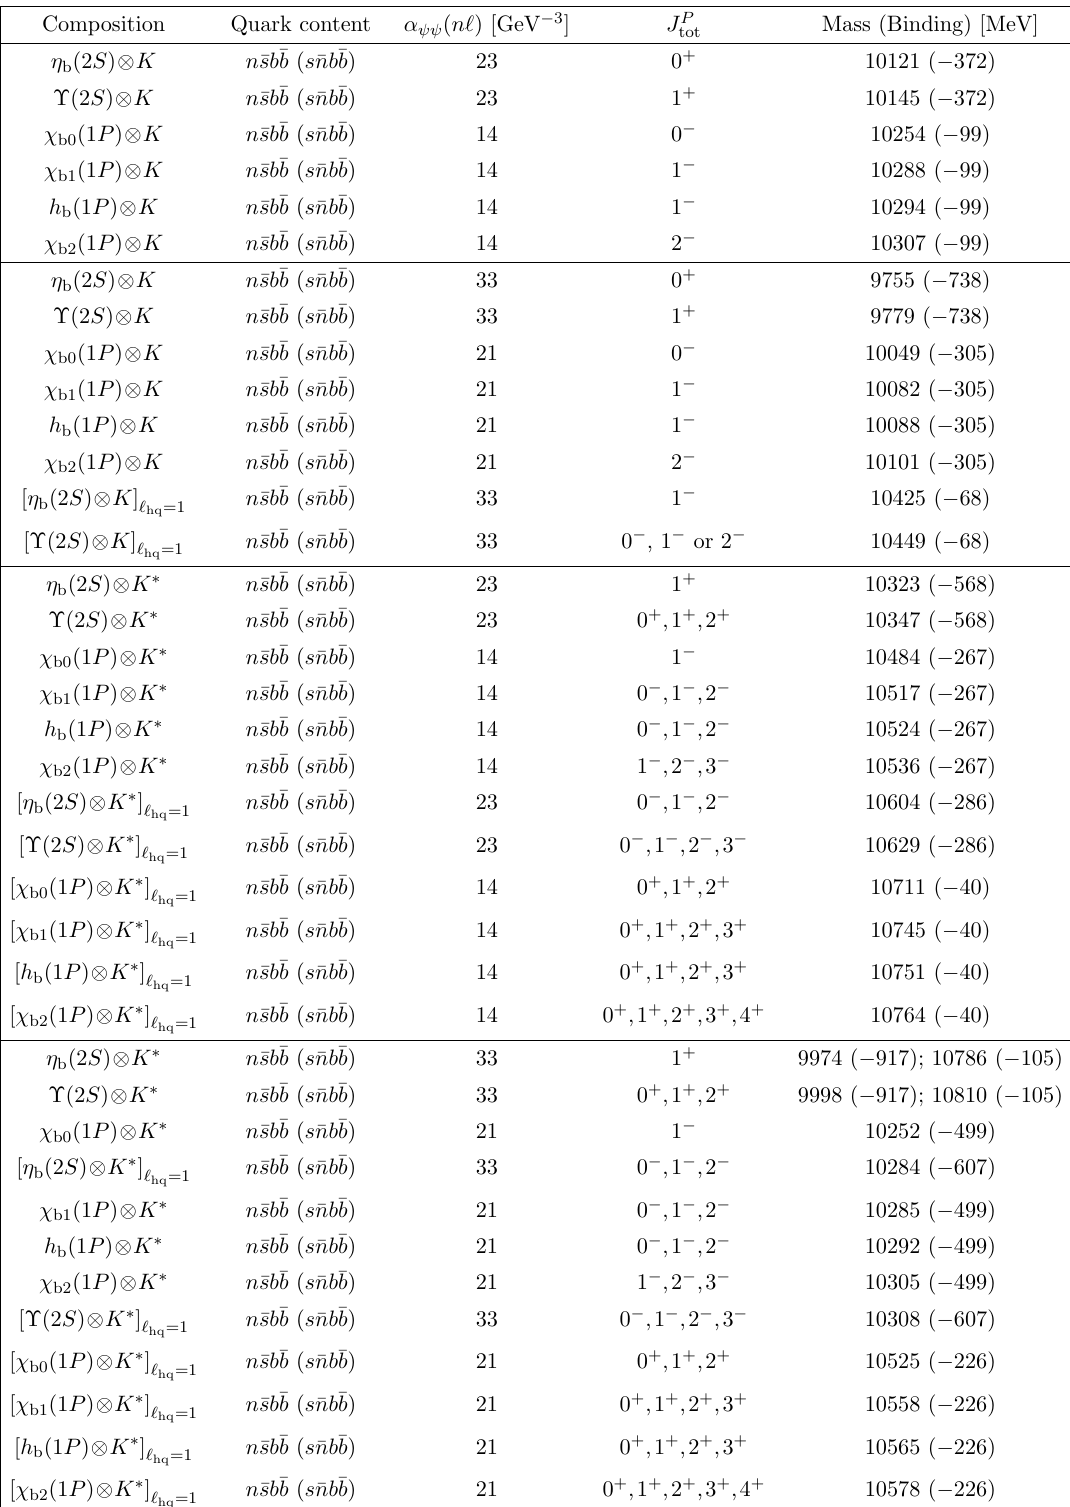
Table 5 . As table 2, but for bottomonium- K and K (cid:3) (892) bound states.